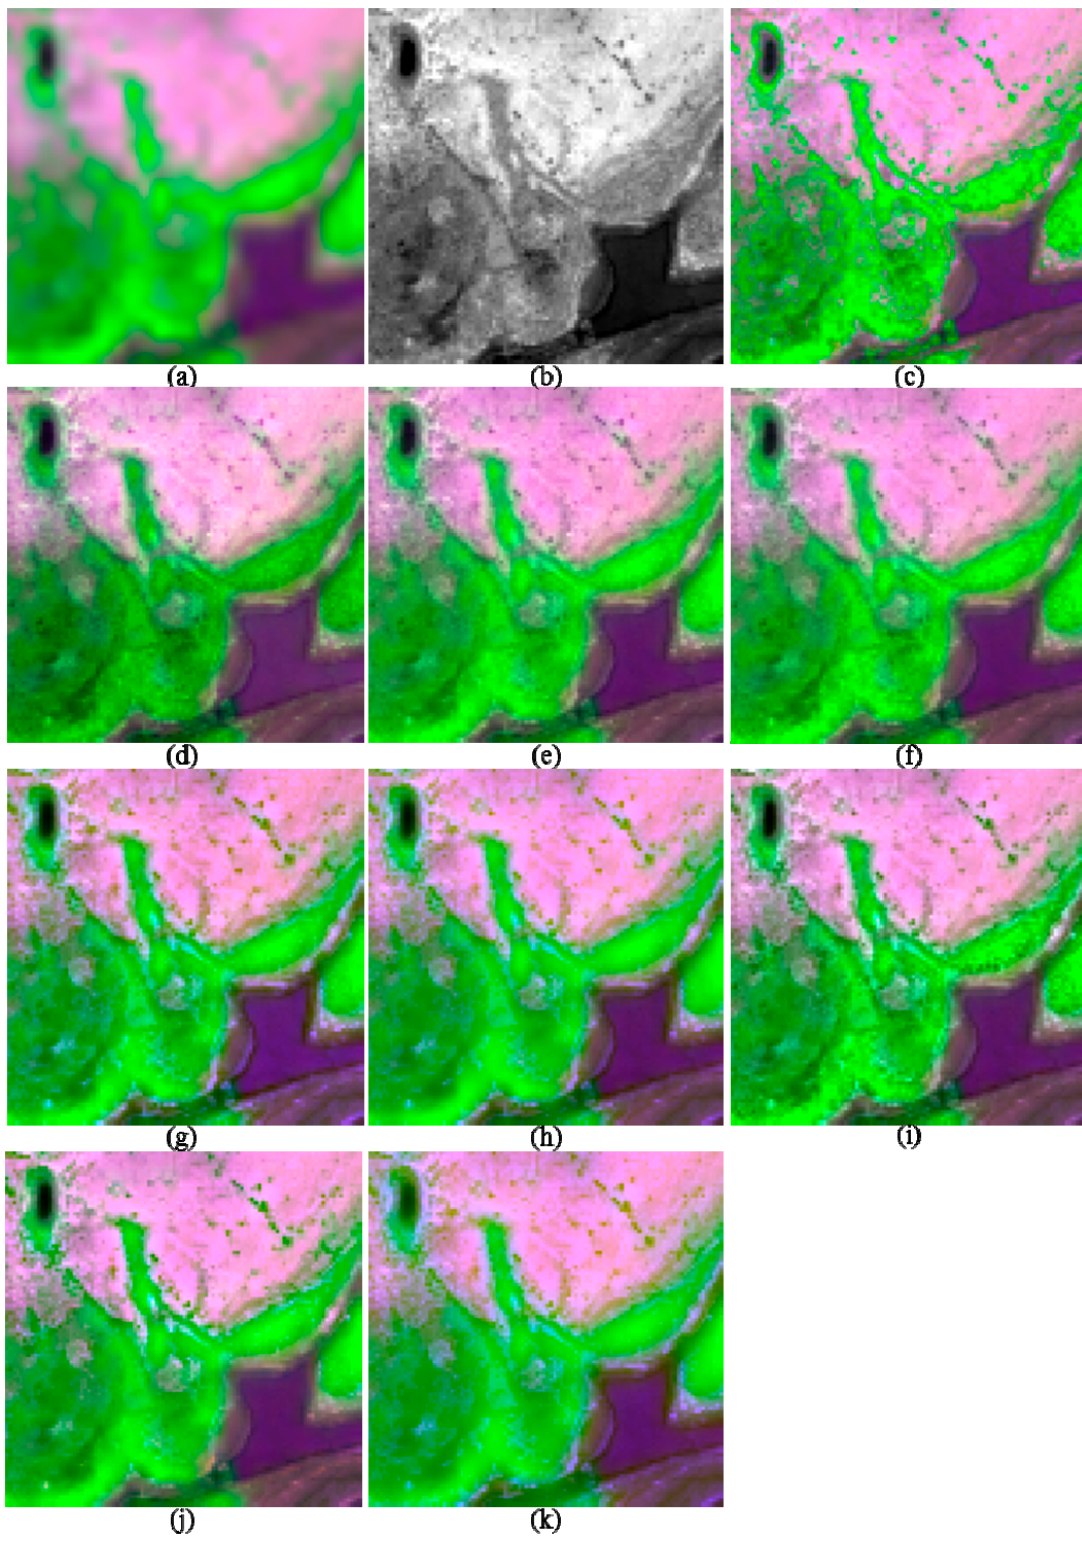
Figure 8. The original and 2-m fused images of I6, shown in band 5-7-2 composition. ( a ) 8-m MS; ( b ) 2-m PAN; ( c ) True 2-m MS; ( d ) GS; ( e ) GSA; ( f ) HR; ( g ) HCS; ( h ) ATWT; ( i ) GLP_ESDM; ( j ) GLP_ECBD; and ( k ) NSCT_M2.